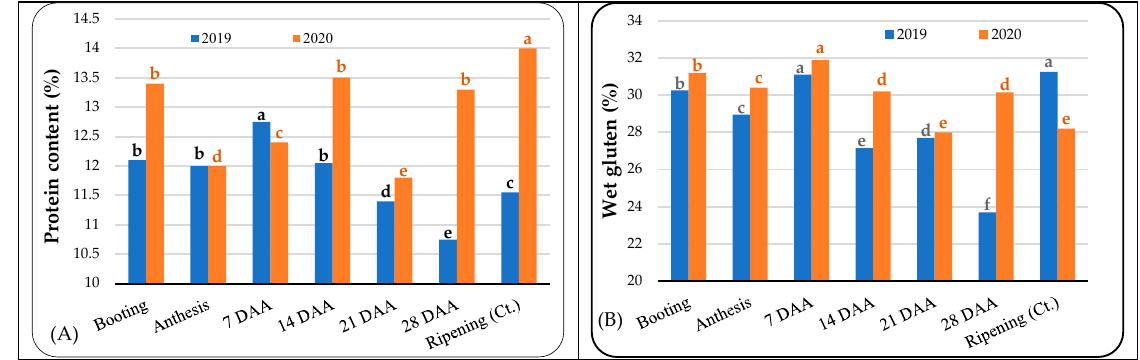
Figure 5. The variation of grain-quality indices (( A ) protein content; ( B ) wet gluten content) under different flag leaf removal stages in Ciprian variety. Different letters in ( A ) and ( B ) figures, the significance is represented according to Duncan Test.